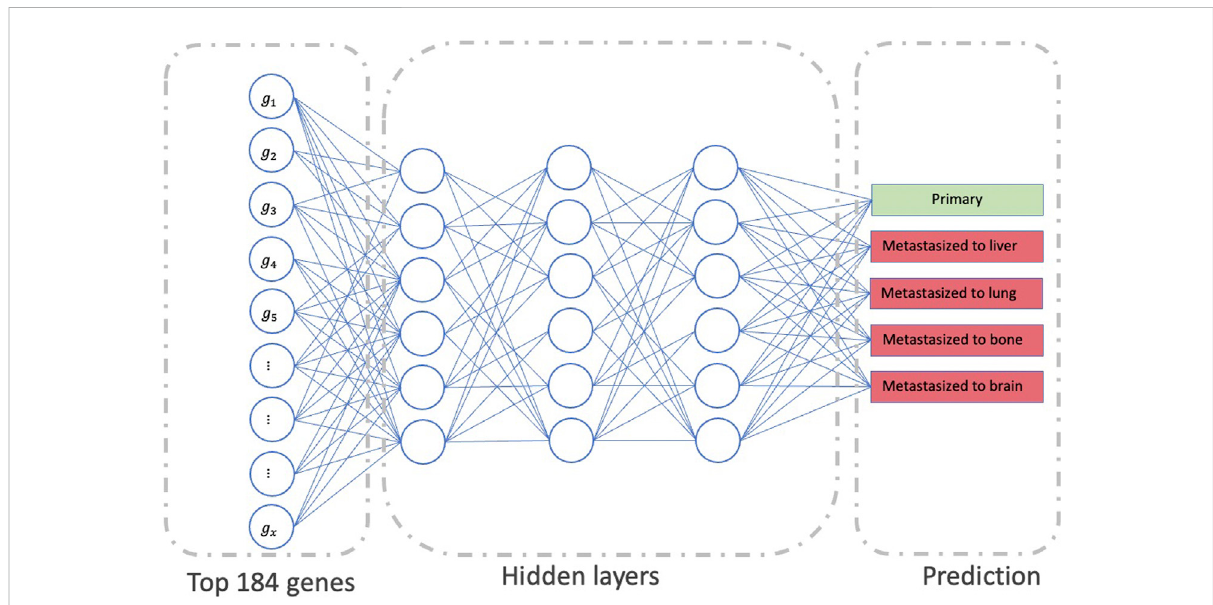
FIGURE 3 The work fl ow represents the second part of our model ’ s framework, which determines the signi fi cant neurons in the network to predict metastasis